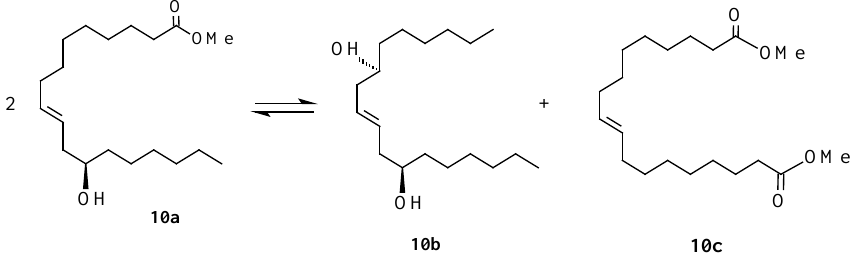
Scheme 5. Self-metathesis of methyl ricinoleate.